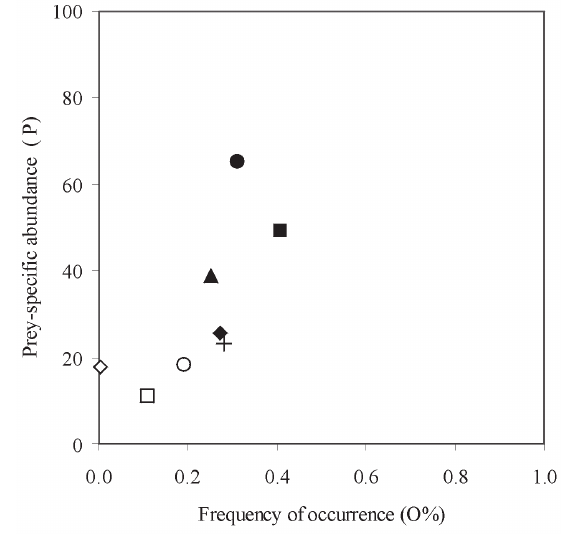
Fig. 4. – graphic representation of diet composition of A. minuta according to the Costello method. T. longicornis ( ò ); A. clausi ( n ); polychaetes larvae ( p ); other copepods ( u ); calanoids (+); decapods larvae ( ô ); Oncaea spp. ( £ ); bivalves larvae ( Ø